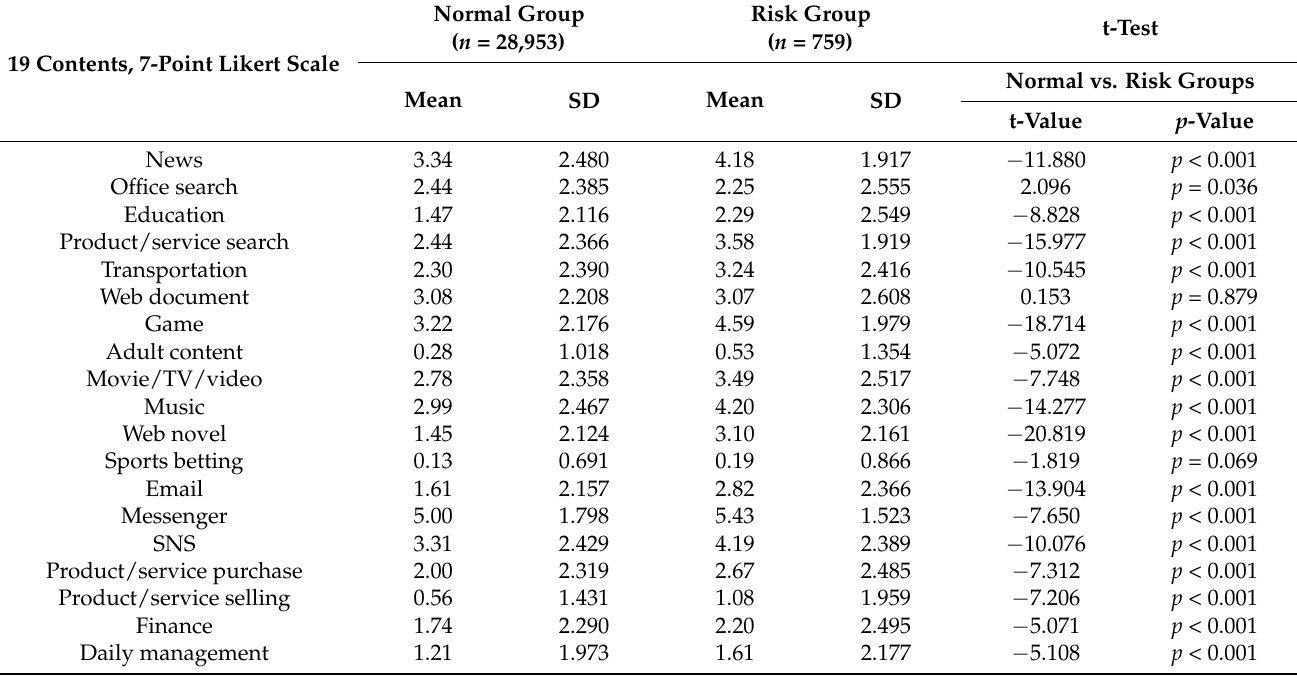
Table 4. Smartphone Usage Level for Each Usage Content.